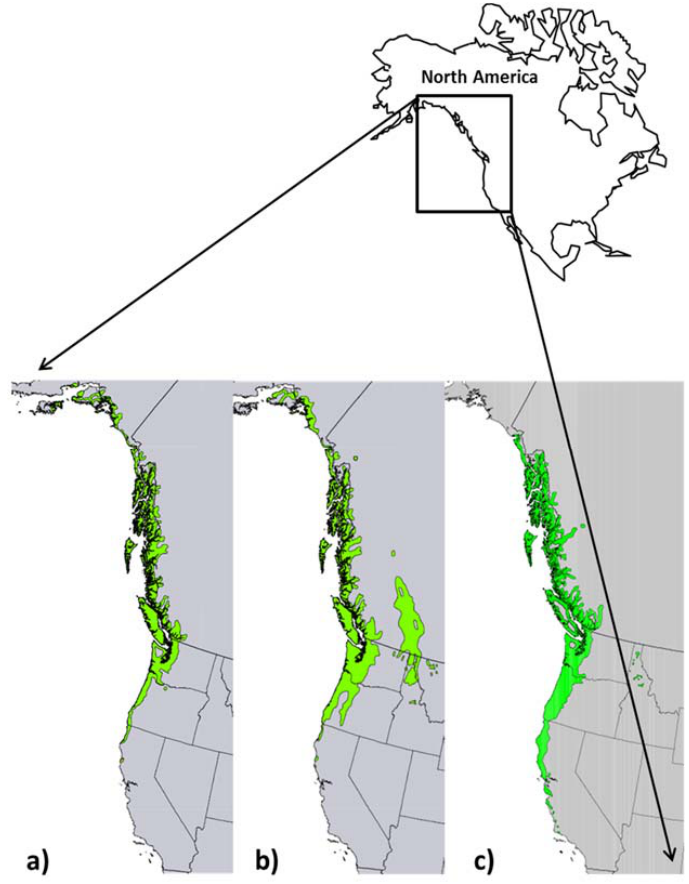
Figure 1. Native distribution of species for ( a ) Sitka spruce ( Picea sitchensis (Bong.) Carr.); ( b ) western hemlock ( Tsuga heterophylla (Raf.) Sarg.); and ( c ) red alder ( Alnus rubra (Bong.)).